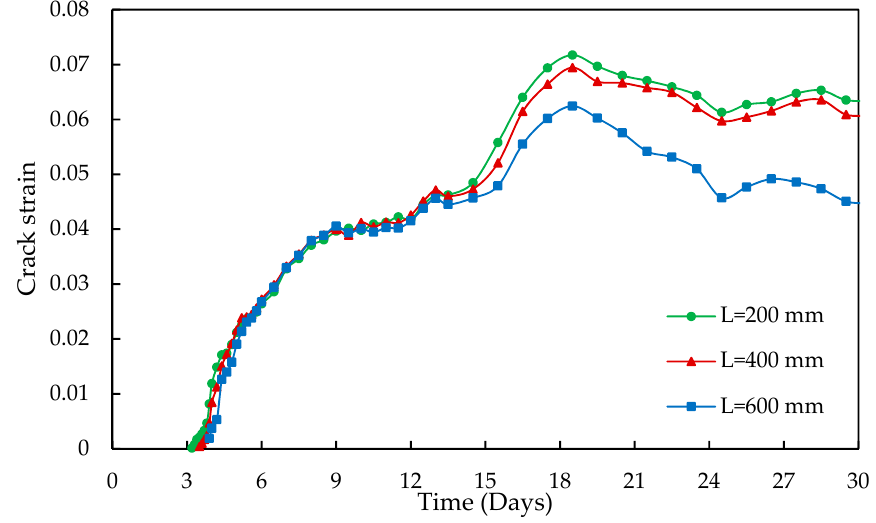
Figure 16. Comparison of crack strain over saw-cut tips for different saw-cut lengths.